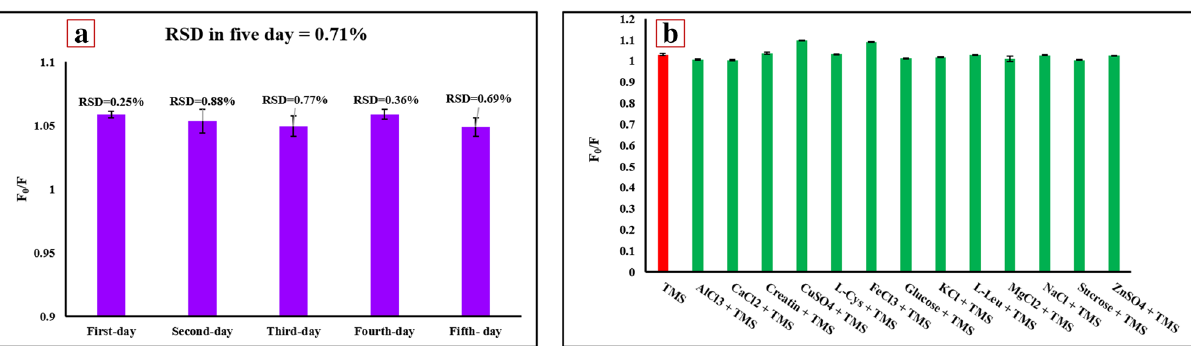
Figure 5. ( a ) Repeatability of RF sensor in five days (Five testes for each day), and ( b ) The influence of a few foreign species on the sensing system (C TMS , C L-Cys , C L-Lus , C methyldopa , C levocarb , and C atenolol = 0.660 μg mL −1 ; C tamoxifen = 1.2 μg mL −1 ; C glucose , C sucaros , C Creatinin , C CuSO4, and C FeCl3 = 3.3 μg mL −1 ; C NaCl , C KCL , C CaCl2 , C MgCl2, and C ZnSo4 = 6.6 μg mL −1 ). Error bars represent the standard deviation from three repetitions of tests under optimal